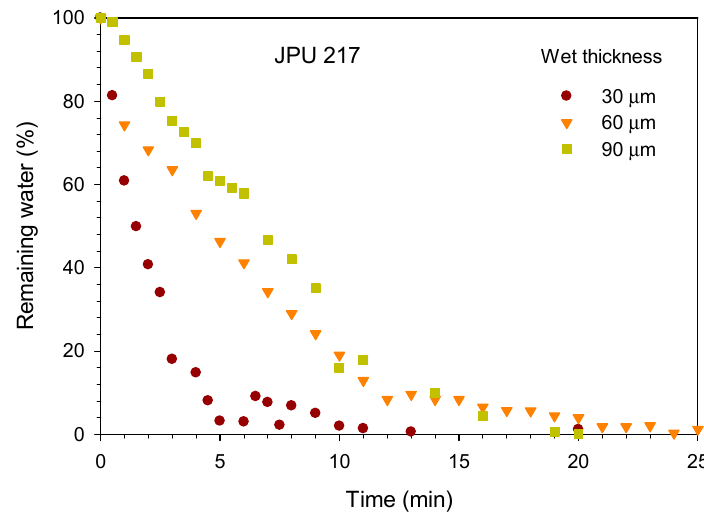
Figure 3. Effect of wet thickness on the drying time of JPU 217.